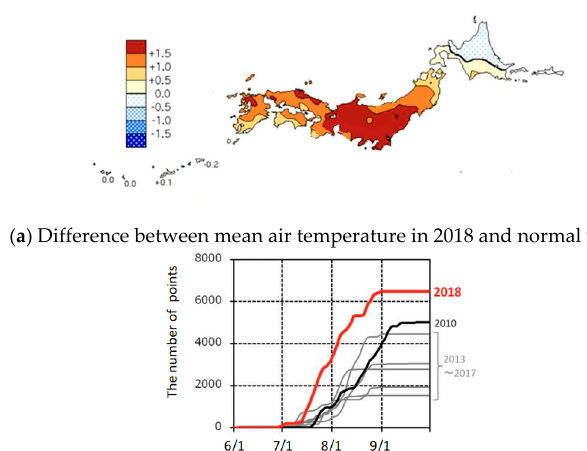
( b ) The number of points observed when the maximum temperature of the day is higher than 35 °C in Japan in recent years. Figure 3. The climate of Japan in summer 2018 [26].